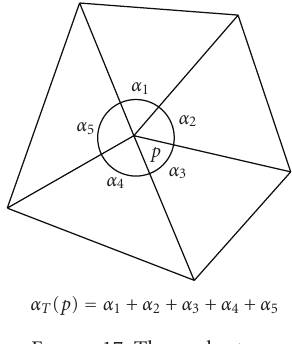
Figure 17: The angle at p .